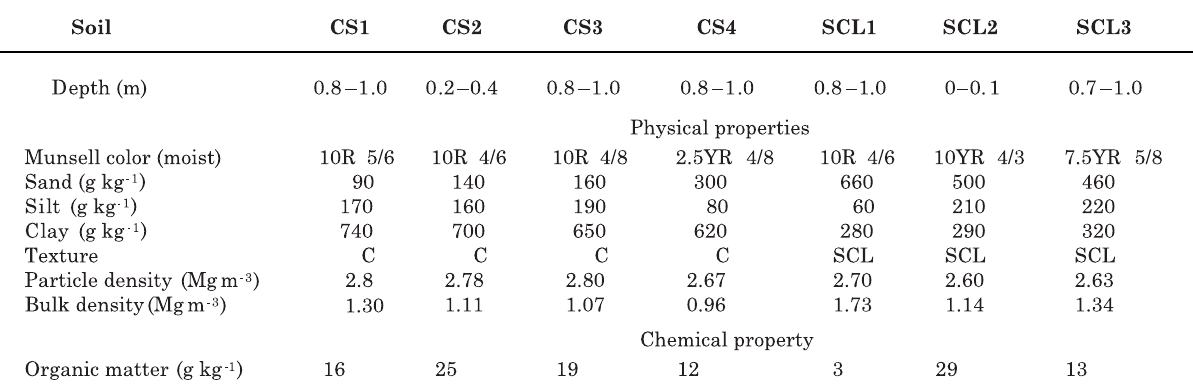
CS: clay soil; SCL: